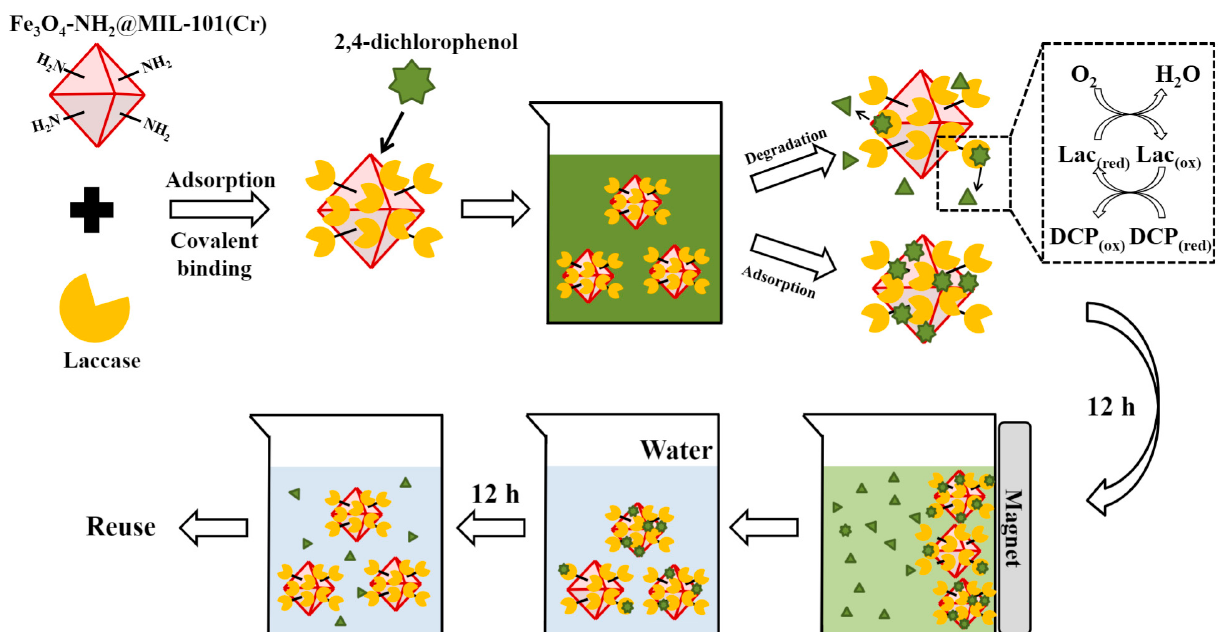
Figure 4. Removal of 2,4-dichlorophenol by laccase enzyme immobilization on MOF (Fe 3 O 4 -NH 2 @MIL-101(Cr)) Reprinted from [89] with permission from Elsevier. Copyright © 2021 Elsevier B.V. License Number: 5174580396809.